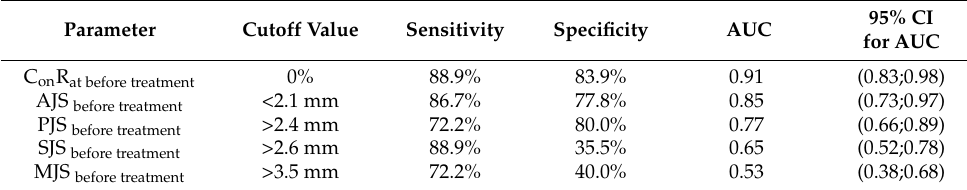
Table 11. The results of the ROC curves analysis.